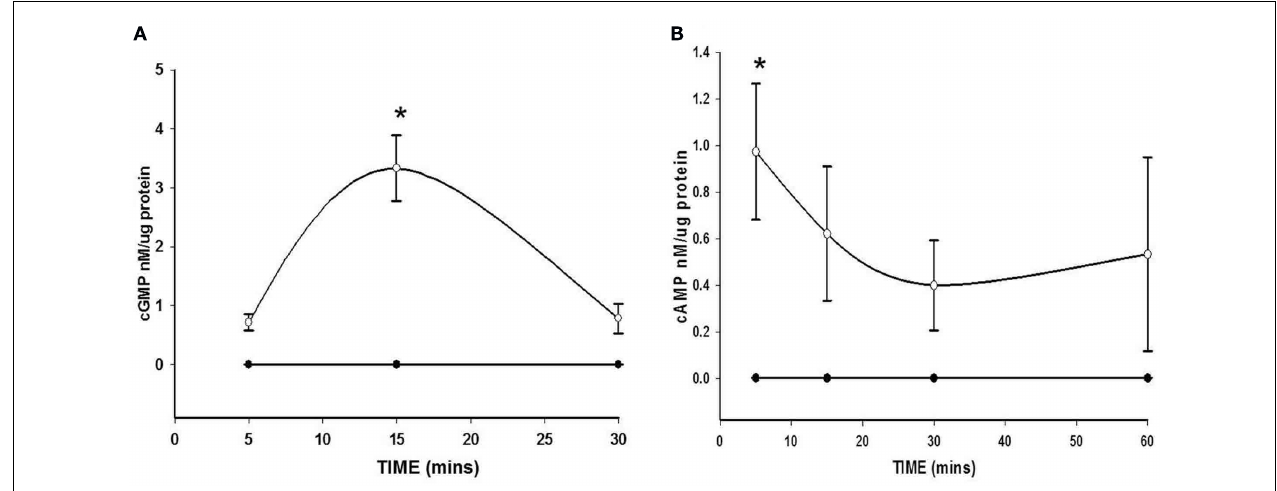
from control ( P < 0.05). (B) VSMCs were treated with BAY (1nM, open circles) or vehicle (filled circles) for 5, 15, 30, and 60min ( n = 6).Values are the means ± SE. *Different